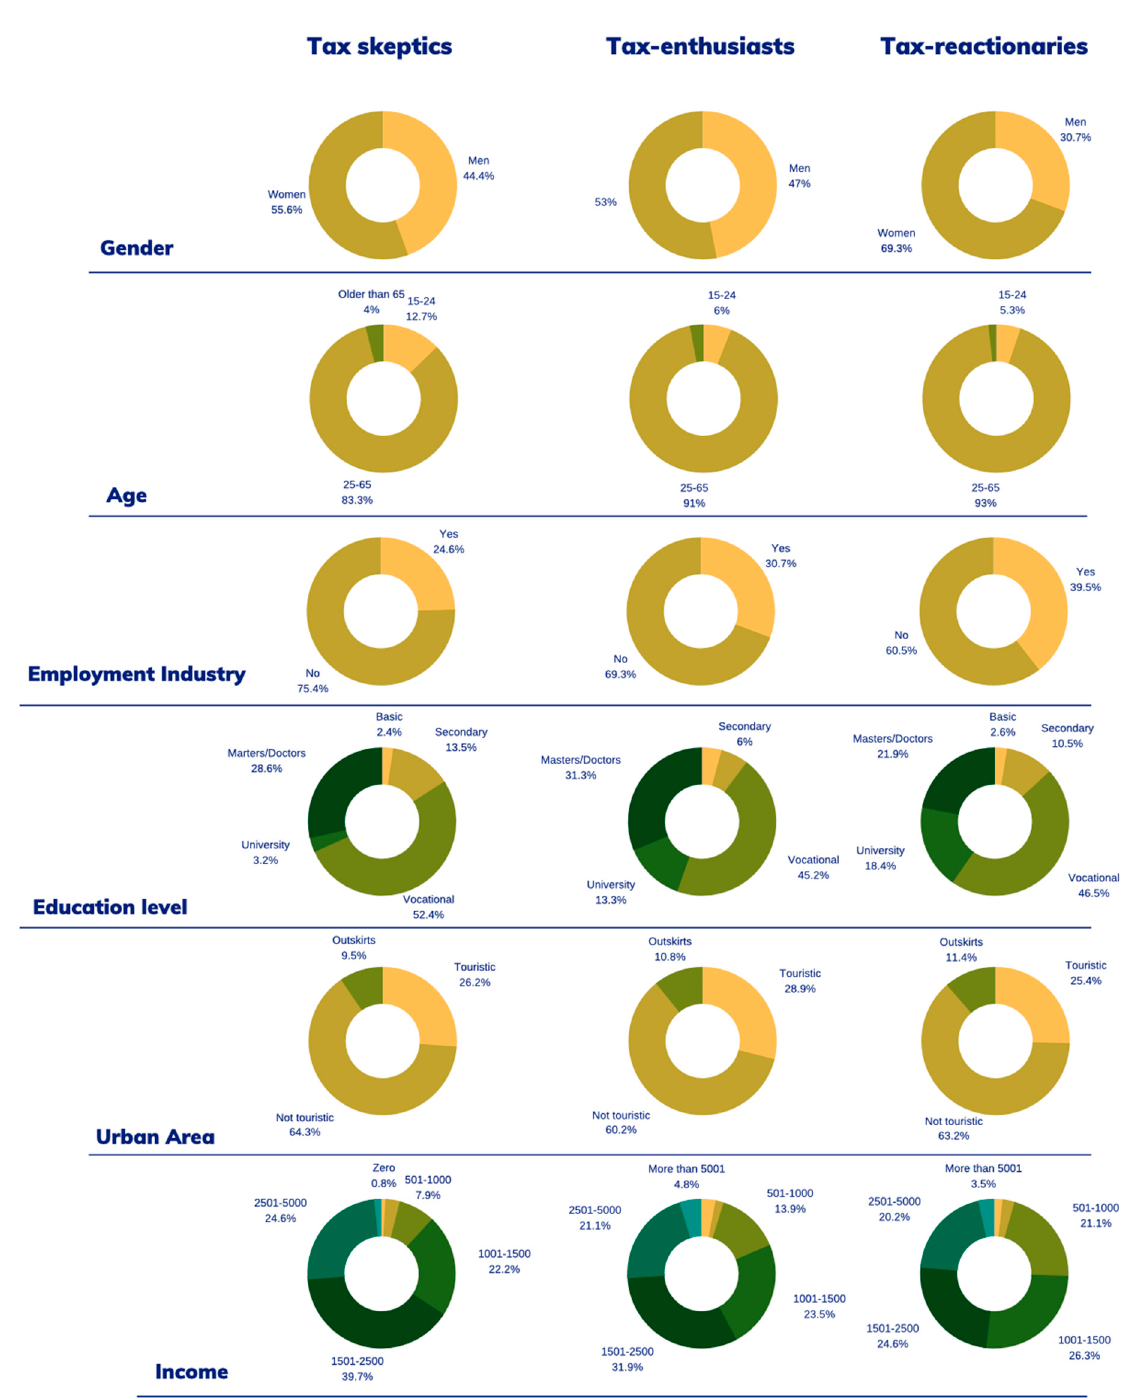
Figure 4. Cluster characteristics. Source: own elaboration.